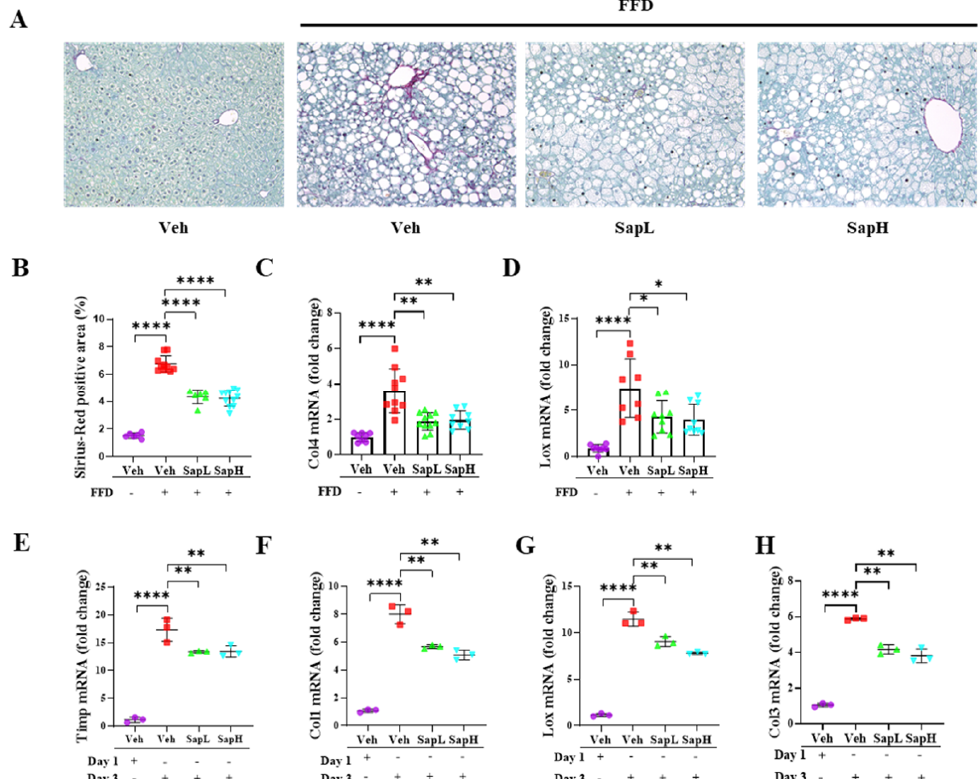
Figure 3. Saponin extract alleviated the FFD-induced steatofibrosis. ( A ) Representative photomicro- graphs of Sirius Red staining of mice liver. Collagen fibers were stained red. ( B ) Sirius red-positive area was calculated as a percentage of the total area. Expression of transcription factors associated with fibrosis, ( C ) collagen type IV (Col4) and ( D) lysyl oxidase (Lox), in liver tissue were measured by qRT-PCR shown as a fold change compared with normal diet mice. The expression of fibrotic genes ( E ) tissue inhibitor of metalloproteinase (Timp), ( F ) Col1, ( G ) Lox, and ( H ) Col3 were measured by qRT-PCR in hepatic stellate cells (HSCs). Relative mRNA expression levels were normalized to mouse GAPDH levels. The data are expressed as means ± sem. * p < 0.05, ** p < 0.01, and **** p < 0.0001.